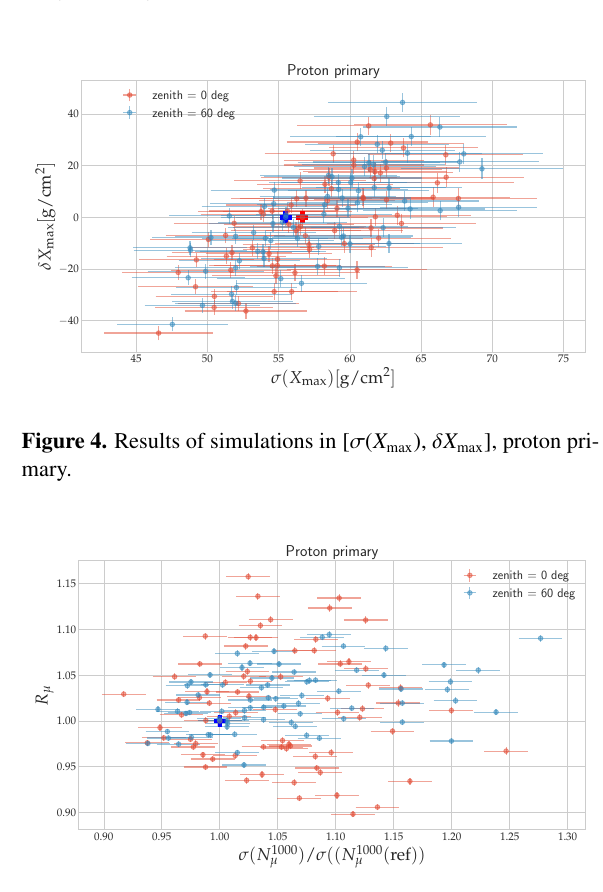
) /σ ( N 1000 (ref)), R µ ], µ µ